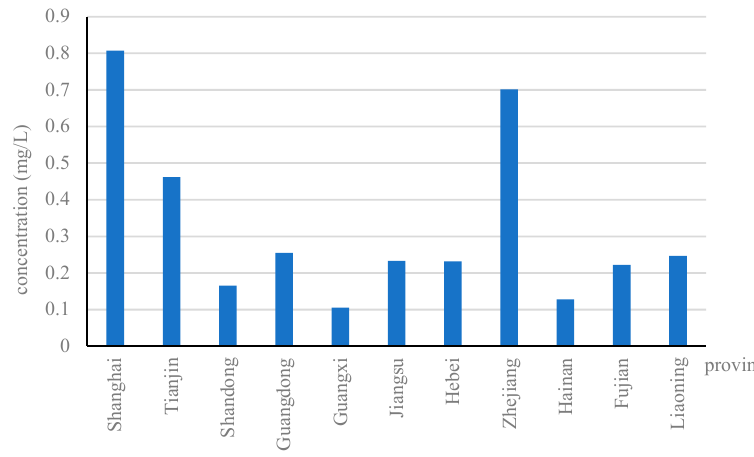
Figure 1. Average concentration of inorganic nitrogen in 11 coastal provinces.